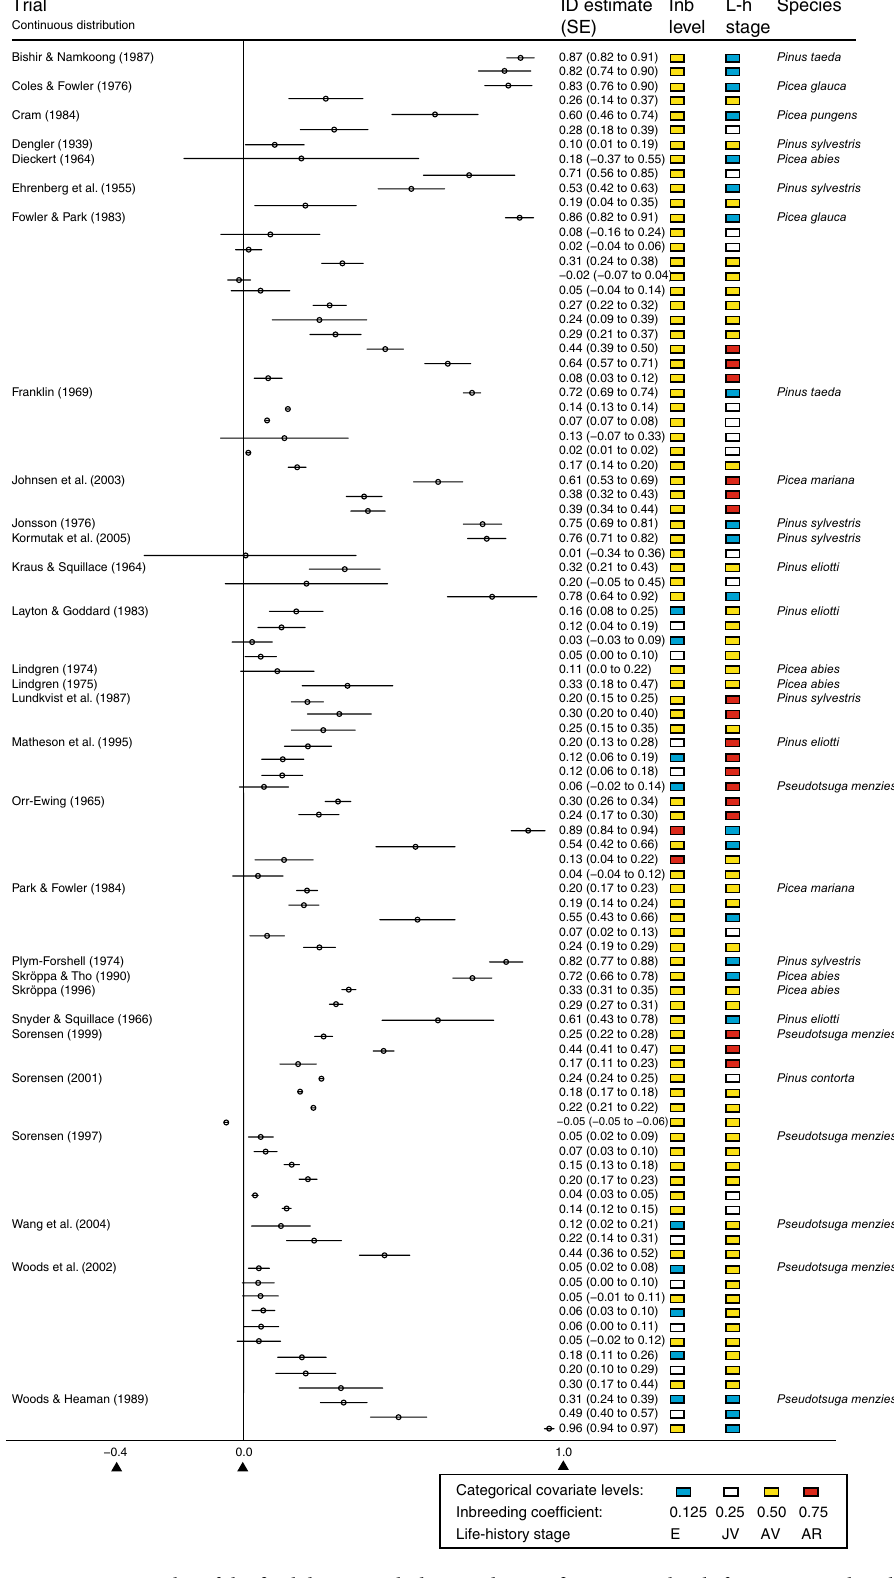
Figure 2. Forest plot of the final dataset including study specific covariate levels for species with well-connected populations. The x-axis shows the level of ID. Life stage and Inbreeding are abbreviated as Life and